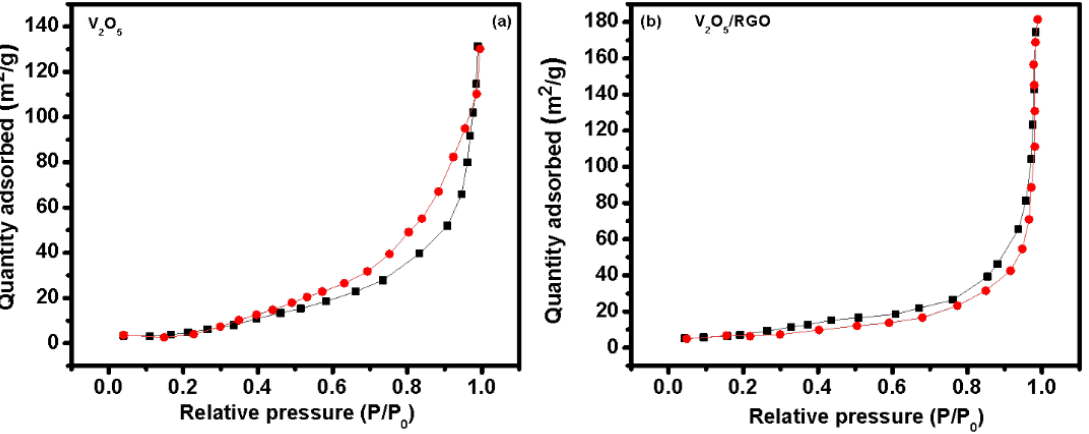
Figure 5. N 2 adsorption/desorption isotherms of the ( a ) V 2 O 5 and ( b ) V 2 O 5 /RGO composite photo- catalysts. photocatalysts. (Black colored dotted line for adsorption and red colored dotted line for